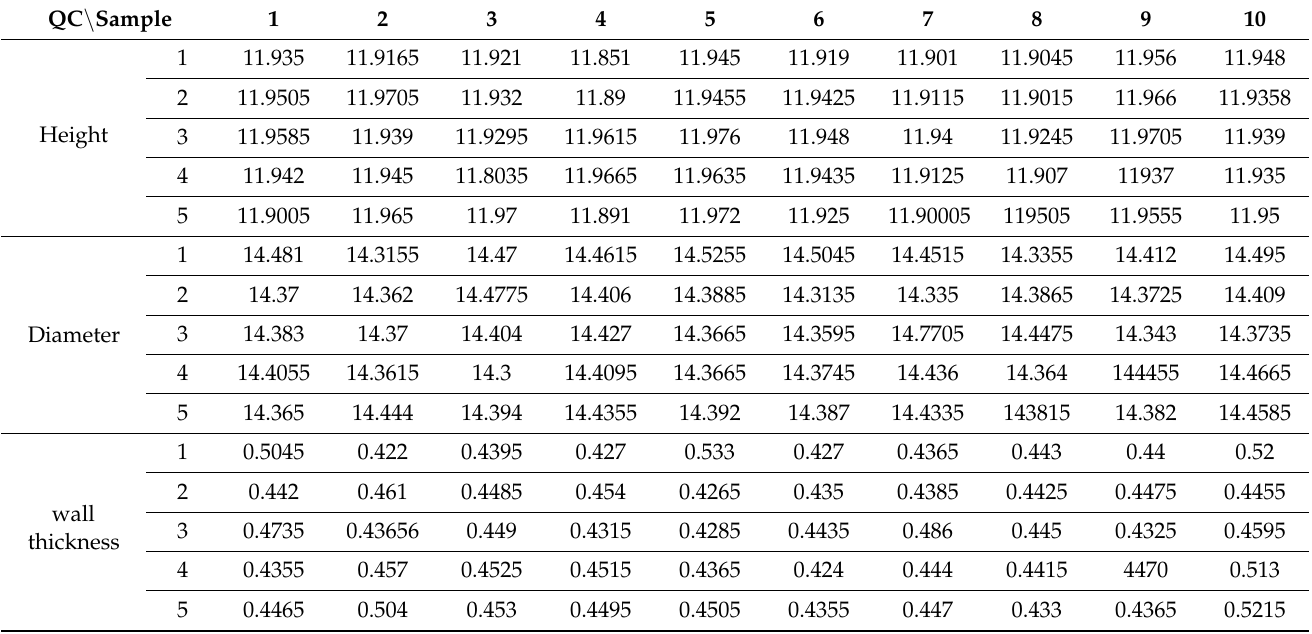
Table 4. Measurements of height, diameter, and wall thickness of 3D-printed